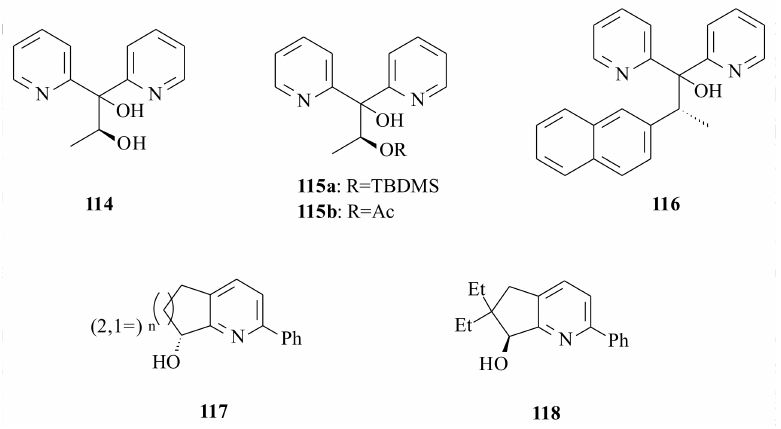
Figure 23. Pyridinyl alcohols used as ligands in the addition of diethylzinc to